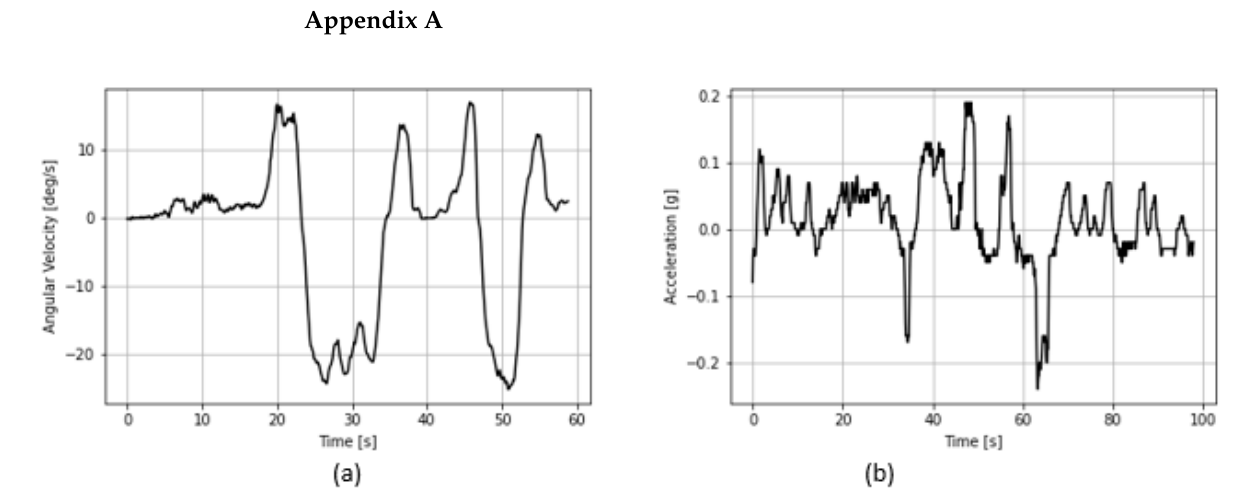
Figure A1. The variations in the ( a ) vehicle’s angular velocity in the roundabout scenario and ( b ) vehicle’s acceleration in the quick changes in acceleration scenario.